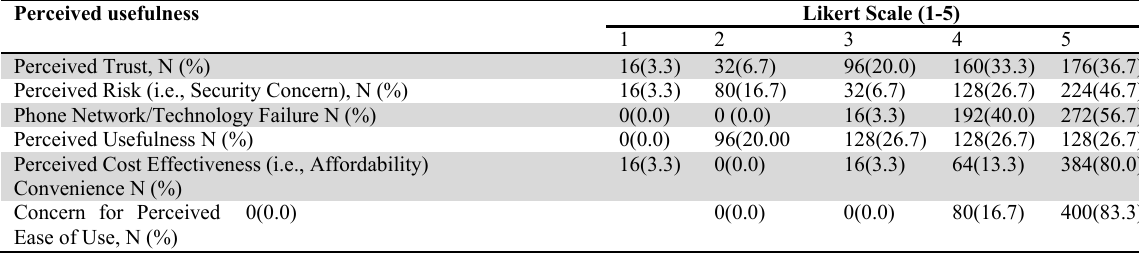
Perceived usefulness of M-money and M-commerce